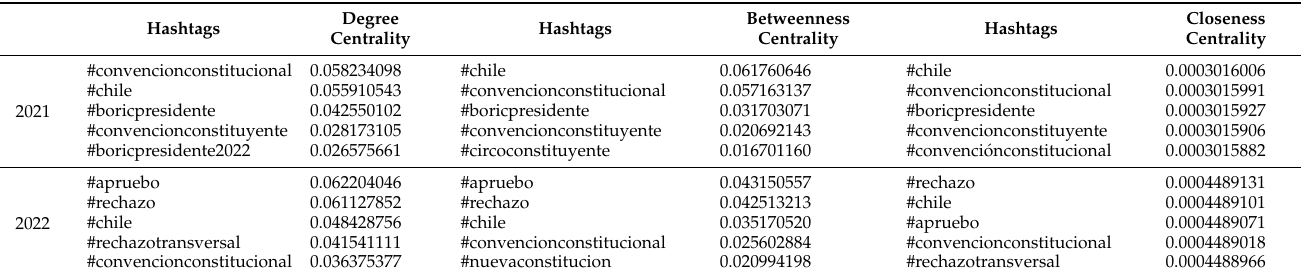
Table 3. Five highest hashtags in local network metrics for “Apruebo Dignidad”.